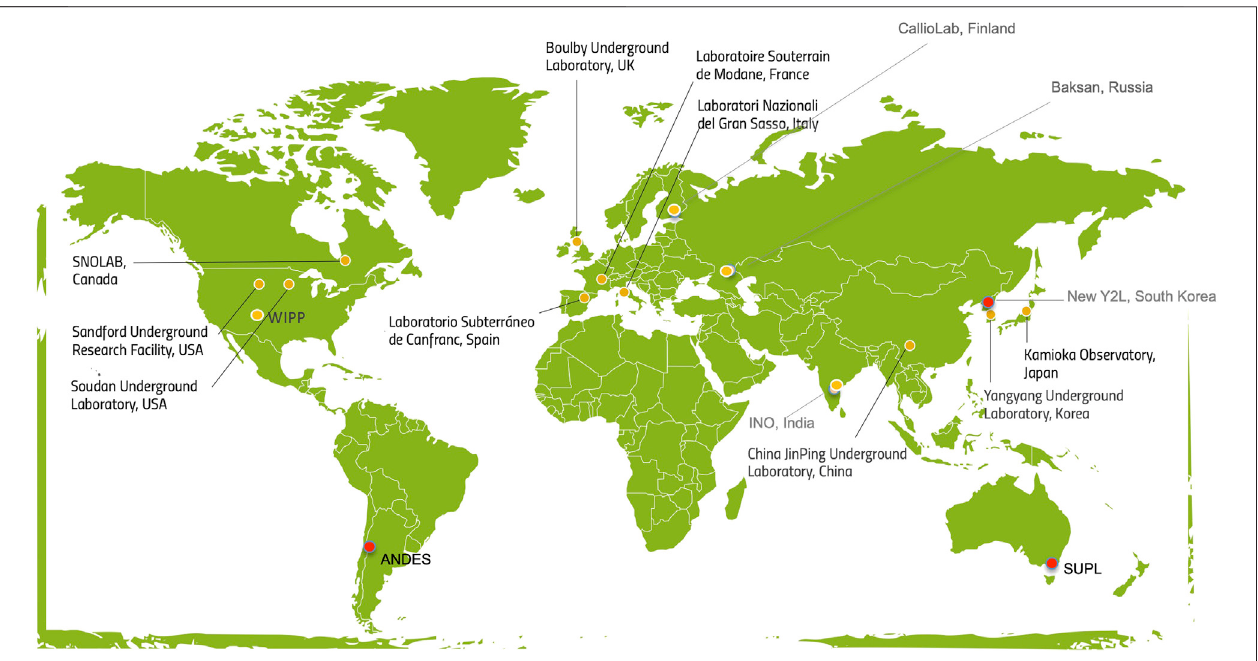
FIGURE 1 | Deep underground laboratories around the World. Geographic location of deep underground laboratories worldwide is shown for existing and future ones. Stawell underground physics laboratory (SUPL) in Australia and the new Yangyang (Y2L) in South Korea are under construction. ANDES in South America is a long-term project.